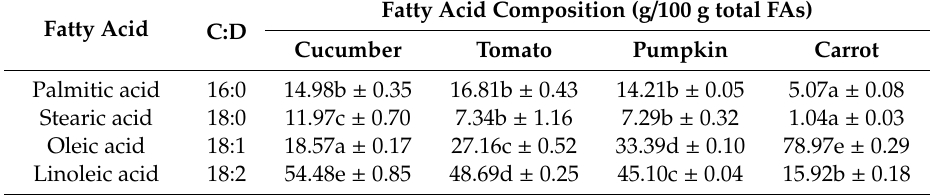
Table 2. Identification and relative concentration of fatty acid compositions in cucumber, pumpkin, carrot, and tomato seed oil samples.